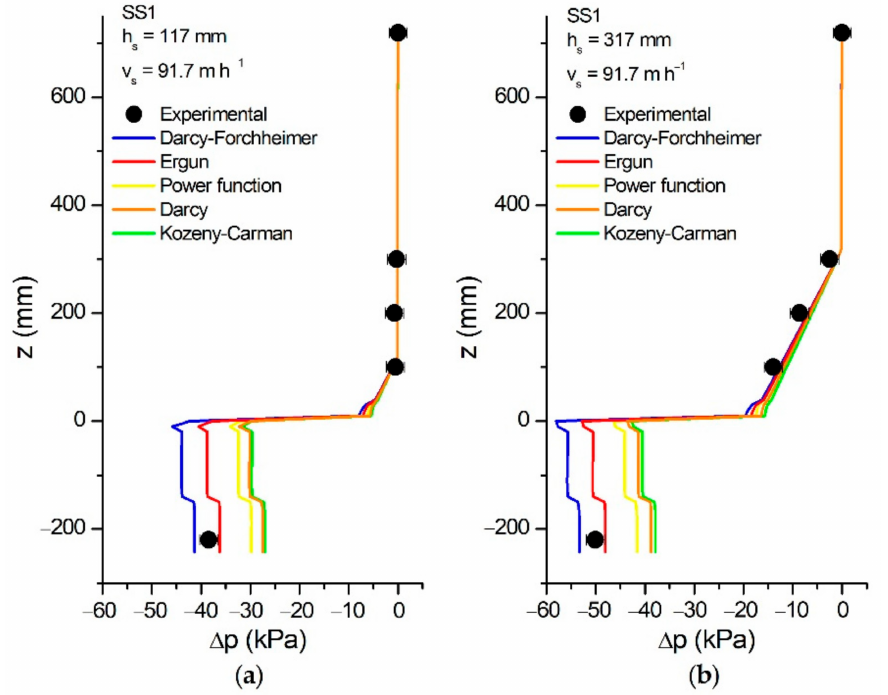
Figure 9. Differences between horizontally averaged values of pressure at different heights and pressure inlet for case ( a ) h s = 117 mm and ( b ) h s = 317 mm both at Q = 0.8 l s − 1 and SS1 media. Vertical profile data for case h